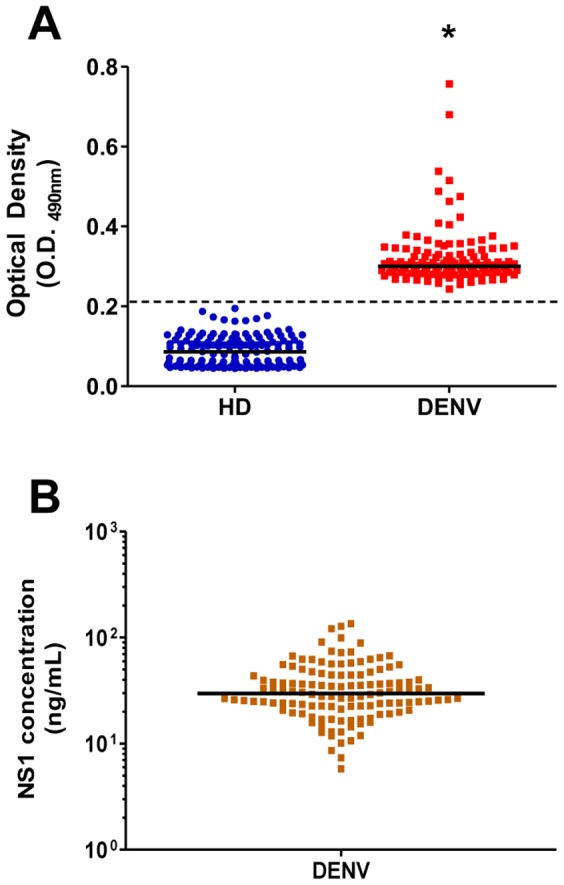
Development of a lab-based ELISA to detect NS1 antigen from the four serotypes of DENV-positive samples.Protein G-purified anti-rNS1 polyclonal antibodies from DENV2 and DENV4 were used as the capture (produced in mice) and detector (produced in rabbits) antibodies for the capture ELISA. Validation of this methodology was performed using purified rNS1 protein from the four serotypes and serotyped serum specimens (data not shown). (A) Determination of the optical density (O.D490nm) values from the 128 samples used in this work (DENV) and from 145 negative samples from apparently healthy blood donors (HD). (B) A standard curve was established using purified rNS1 proteins from the four DENV serotypes, and the O.D.490nm values were converted to NS1 concentrations in ng/mL. A p value less than 0.05 was considered statistically significant. *p<0.001.